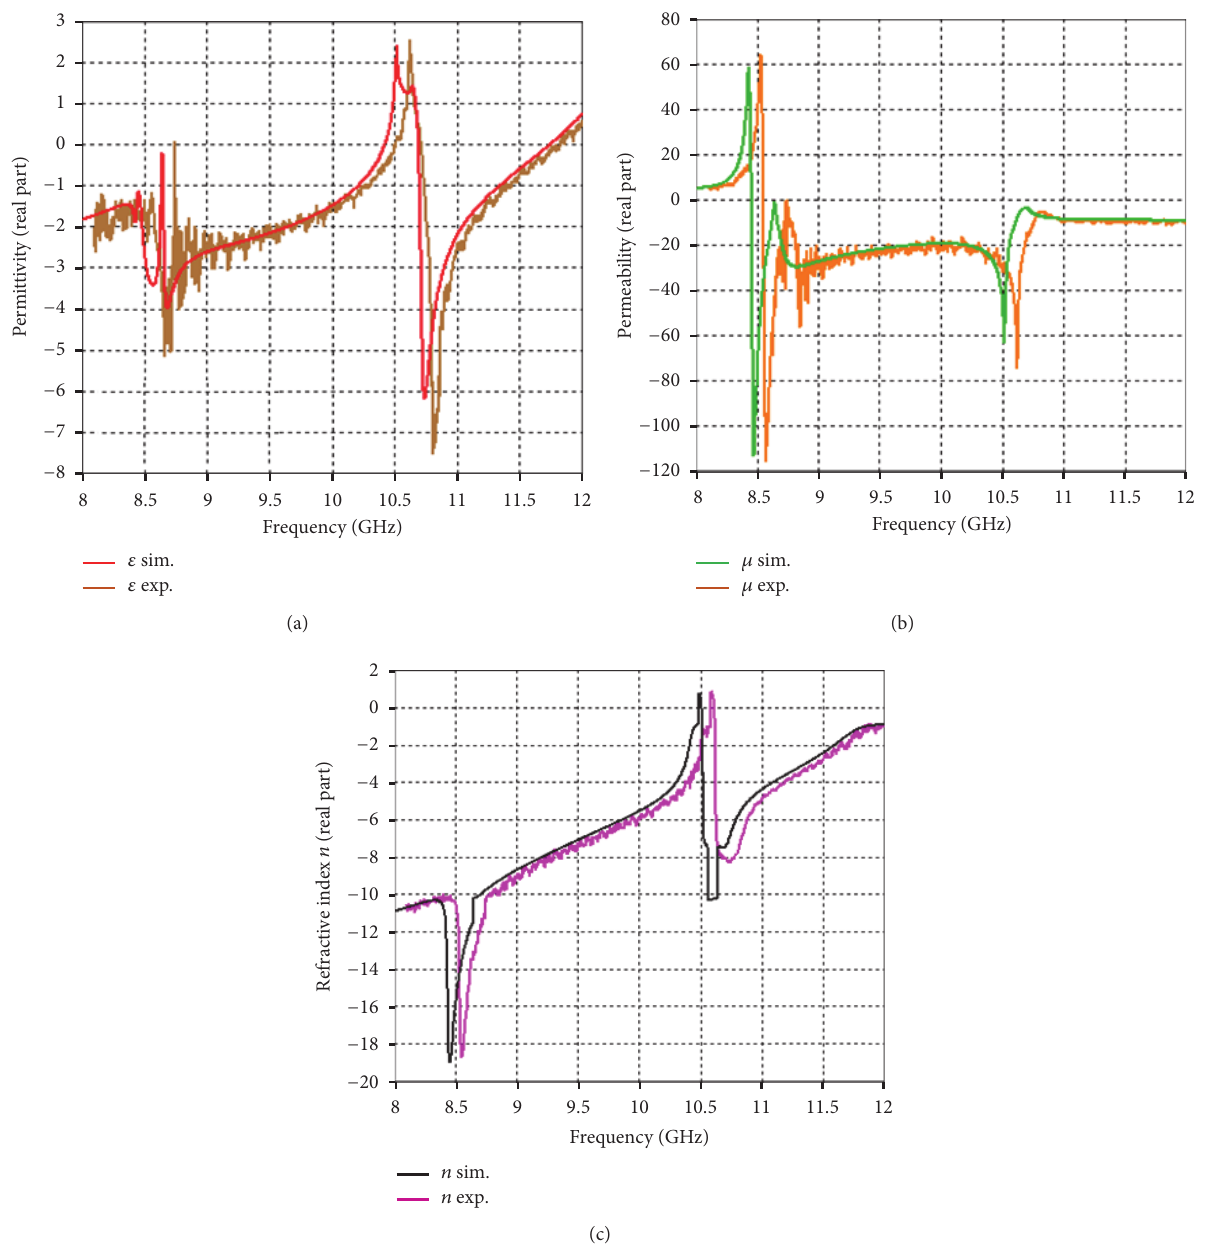
Figure 7: The simulated and experimental results for the real parts of (a) permittivity, (b) permeability, and (c) refractive index.